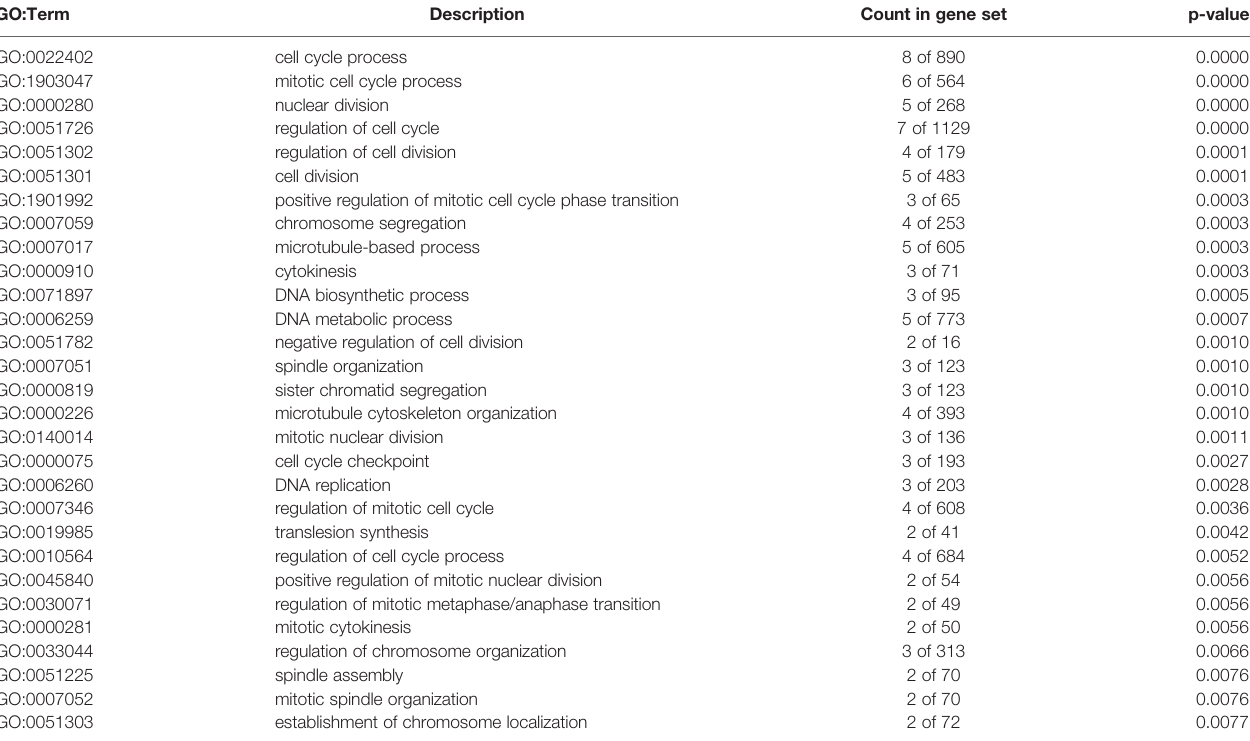
TABLE 3 | GO enrichment